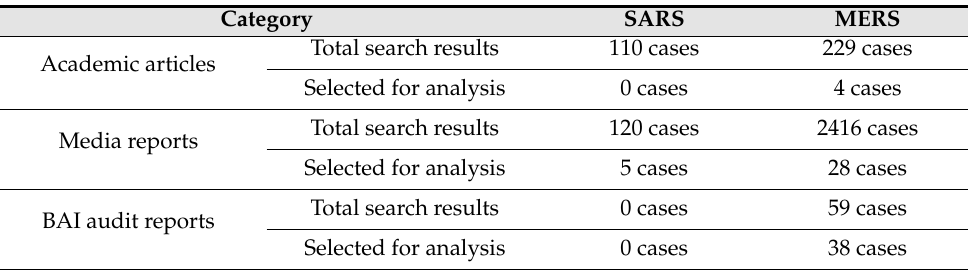
Table 1. Analysis of